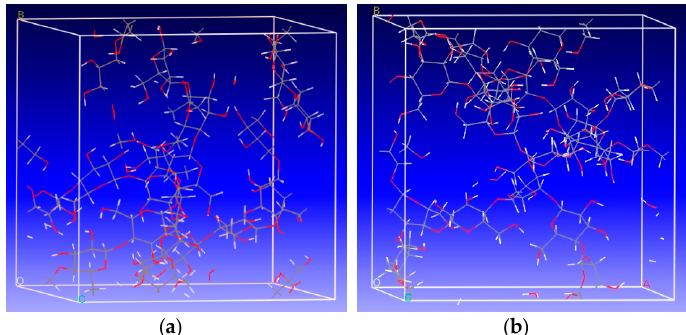
Figure 1. Models in the amorphous region of cellulose with DP of 10 calculated using ( a ) the COMPASS force field and ( b ) the PCFF force field.